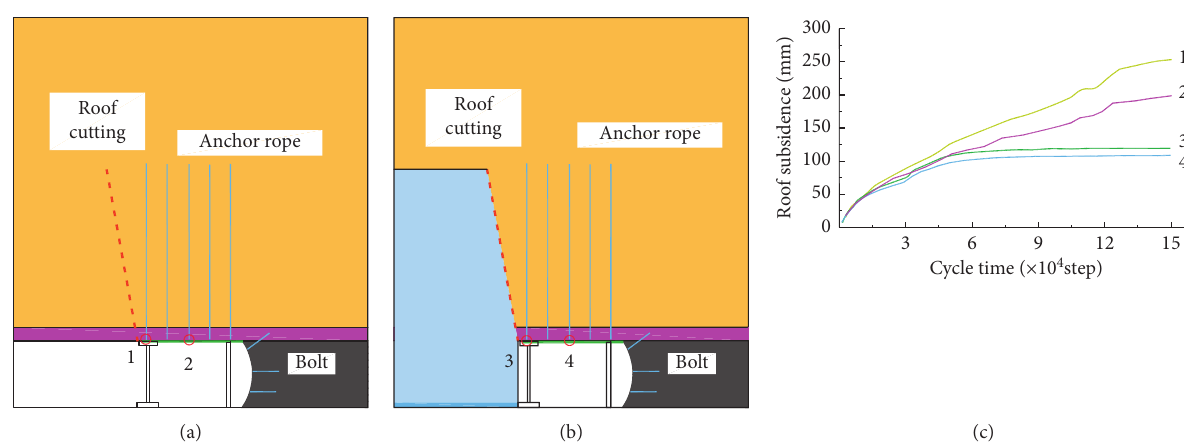
Figure 7: Schematic diagram of the monitoring and the results of roof displacement monitoring: (a) the first method; (b) the second method; (c) the subsidence of monitor